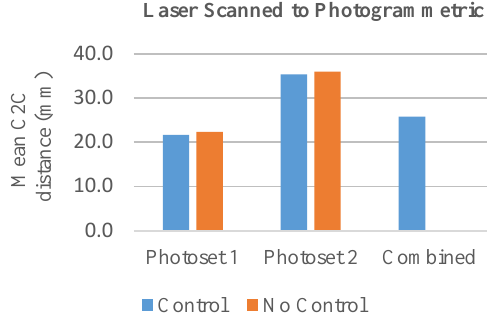
Figure 10. C2C distance testing of models generated from differently arranged photosets The photosets were combined to see if this would improve the reconstruction due to redundancy. This was not the case. Rather, the accuracy was approximately halfway between numbers of photos do not necessarily improve the model; if are more likely to reduce redundancy by causing tie-point ambiguity.